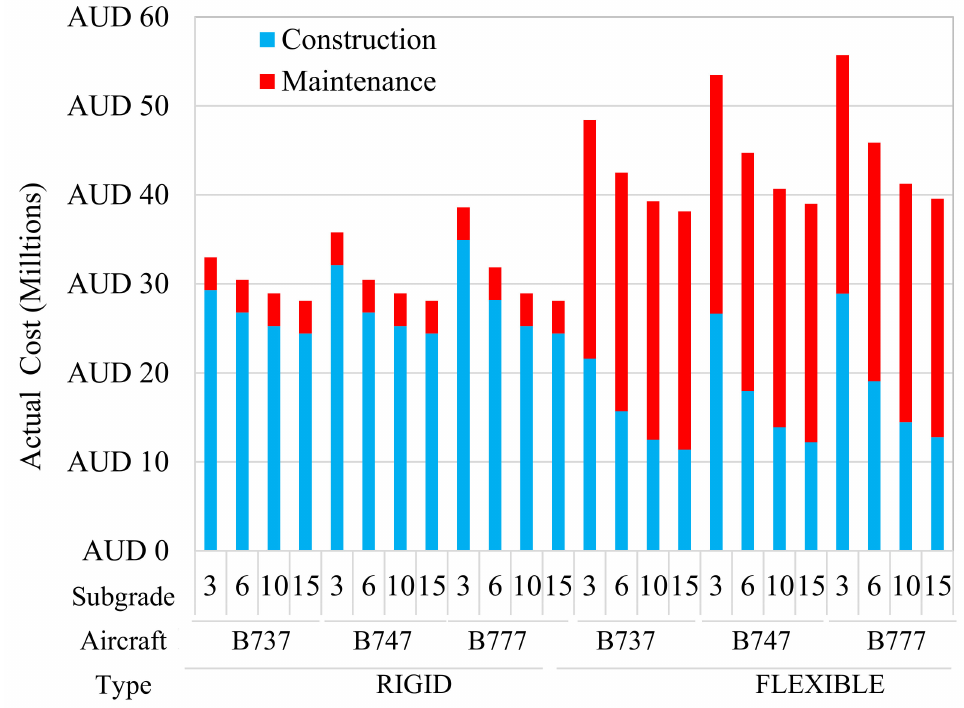
Figure 3. Pavement construction, actual maintenance and total